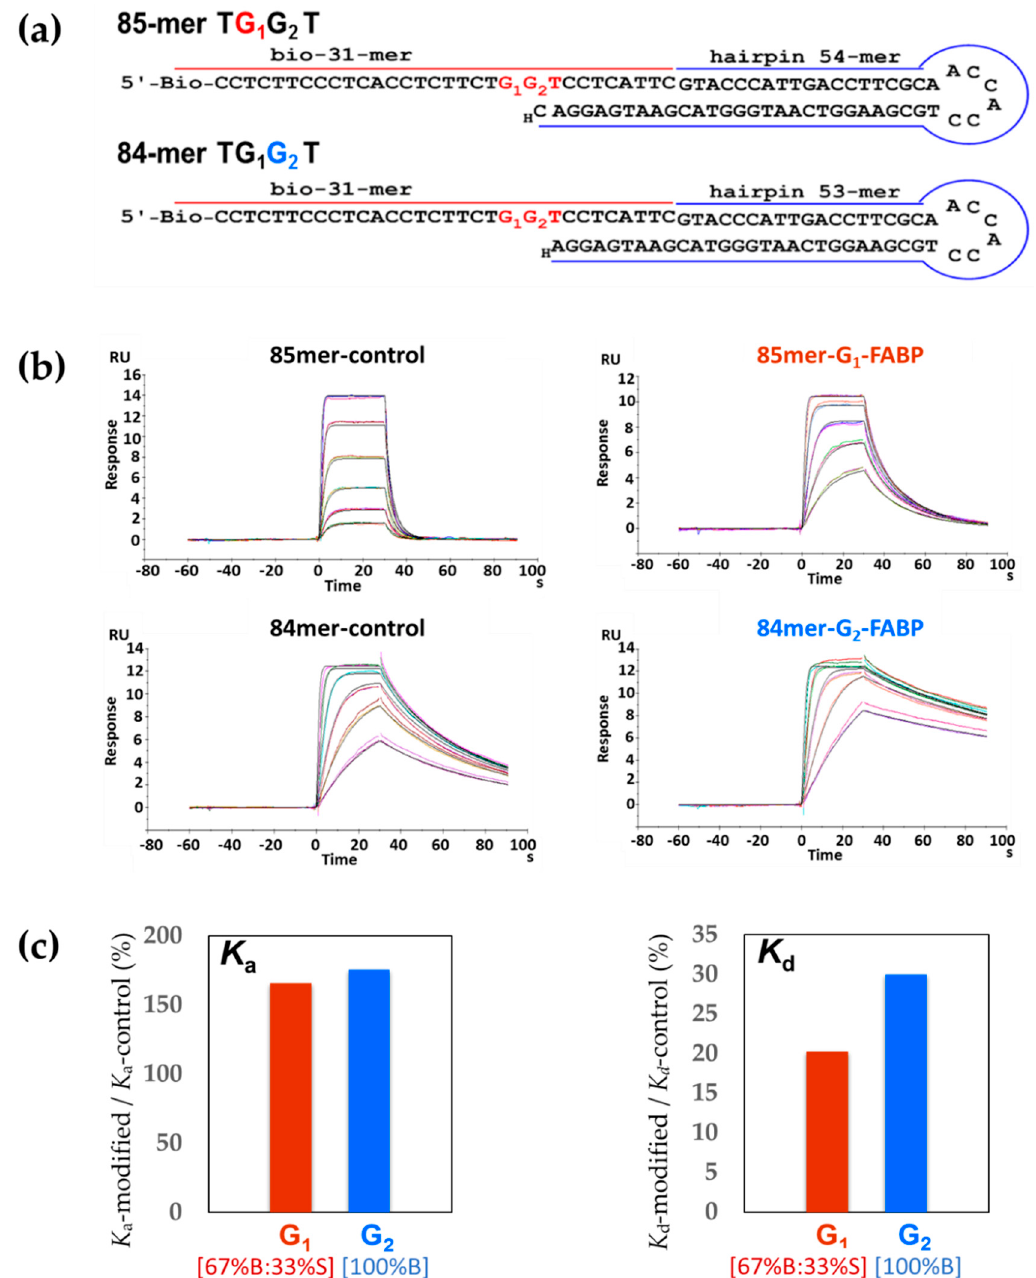
Figure 2. ( a ) Hairpin template − primer oligonucleotide constructs of 85-mer G 1 and 84-mer G 2 for Kf-exo − , H denotes 3 ′ -dideoxy-nucleotide; ( b ) Sensorgrams of binary complexes of Kf-exo − with 85-mer and 84-mer unmodified control, G 1 -FABP and G 2 -FABP modified sequences (1:1 binding fitted curves are overlaid as black lines); ( c ) K a ( K a -modified / K a -contol) and K d ( K d -modified / K d -contol) ratio, G 1 and G 2 represent the ratio of 85-mer FABP-G 1 /85-mer-control and 84-mer FABP-G 2 /84-mer-control, respectively.